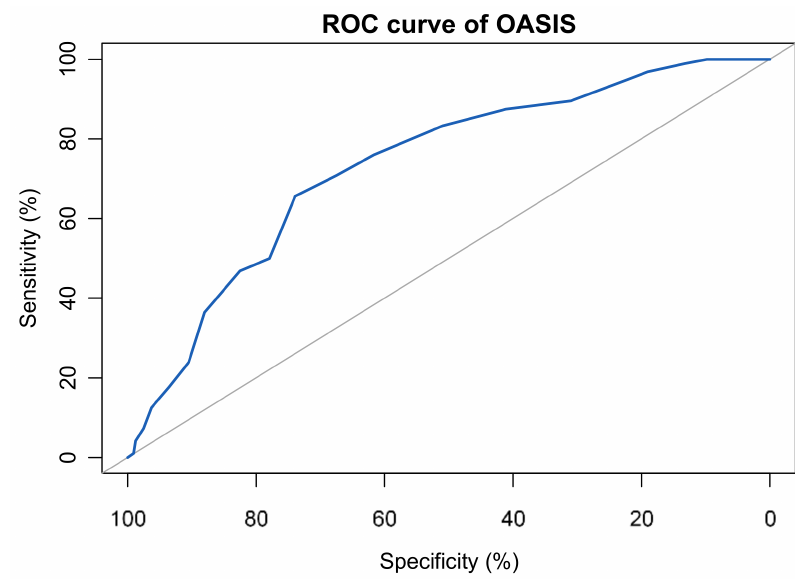
Figure 3. ROC curve of the OASIS (Sample 4, n =